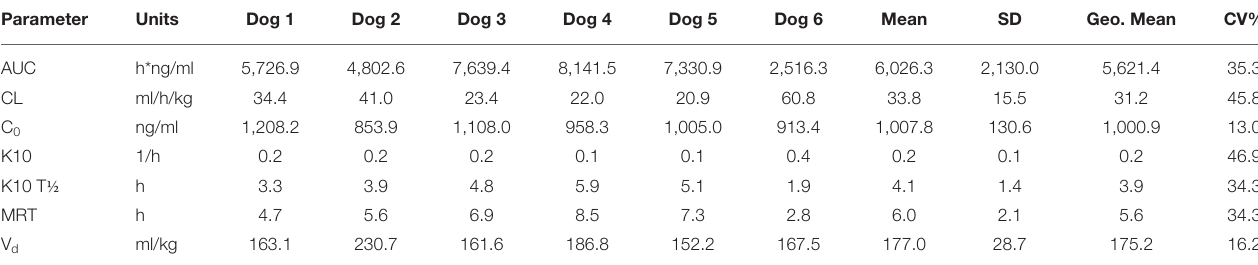
FIGURE 1 | Plasma apixaban concentrations as quantitated by LC/MS and corresponding anti-Xa activity values (aXa) over time following intravenous administration of apixaban (0.18 mg/kg) to 6 healthy mixed-breed dogs. Data presented on the left panels represent mean ± standard deviation values plotted on linear axes, while data on the right panels are displayed on semi-log plots (log 10 concentration and aXa). Where the standard deviation values were smaller than the width of the dot, the error bars are not displayed. Red lines represent the fit line from the one-compartment pharmacokinetic model (see equation in section Materials and Methods) plotted using mean data ( Table 1 ).